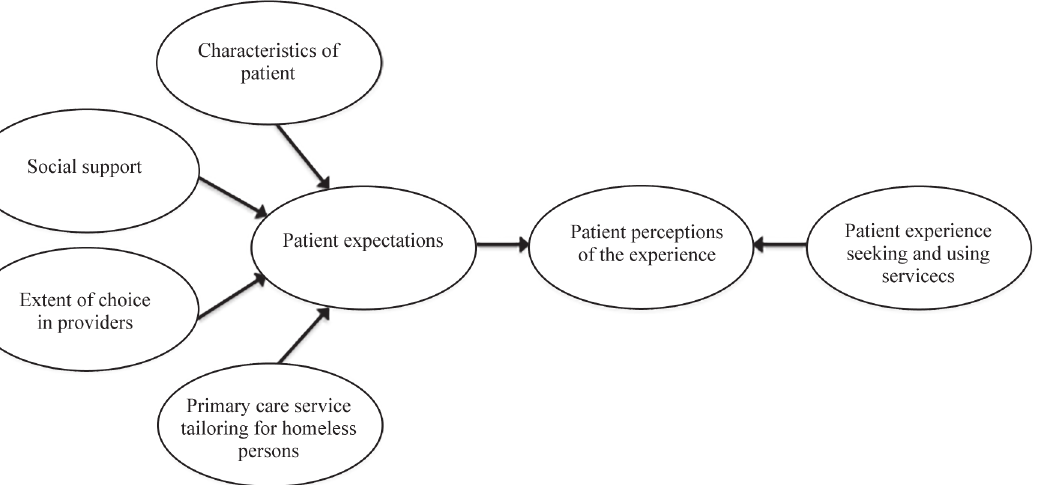
Fig 1. Adapted conceptual framework for predictors of patient care experiences among individual experiencing homelessness. This framework was adapted from Shosanna Sofaer and Kirsten Firminger model of patient perceptions. For the purpose of our analysis, we retained some original variables as well as the general relationship expressed in this model, although the variables are specific to our sample